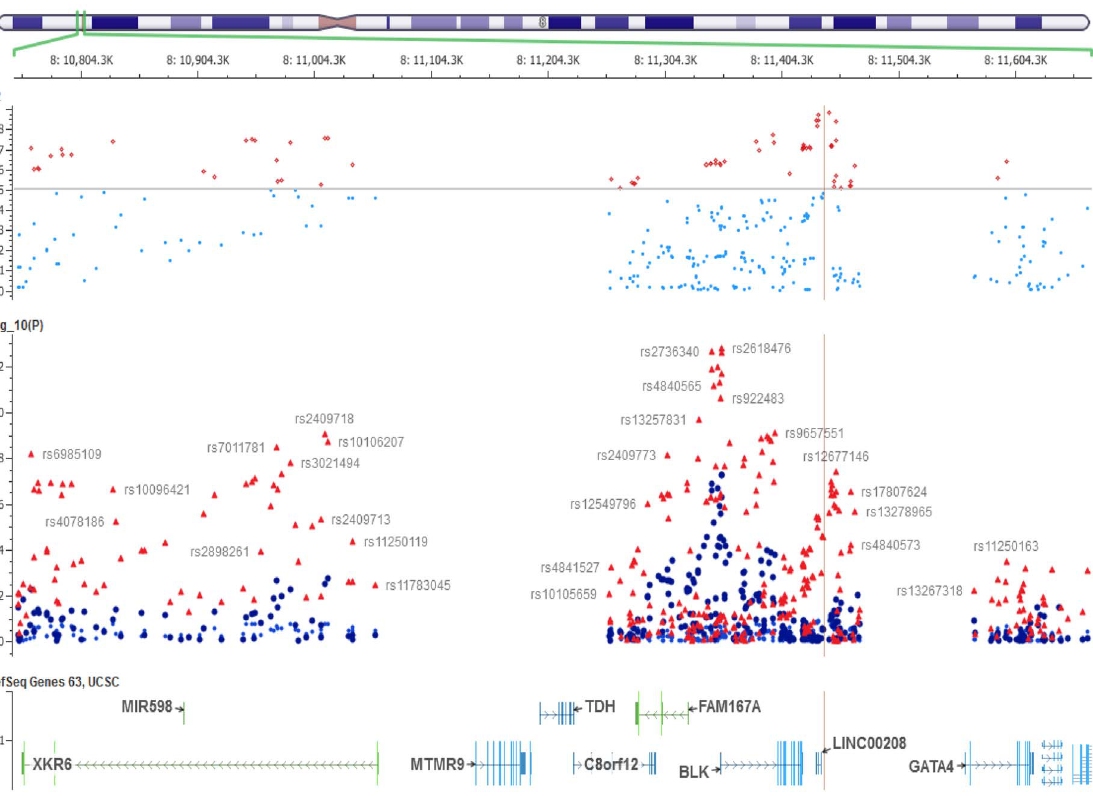
Fig. 5. A schematic representation of the association map for Lupus at 8p23 before and after conditional analyses. Red dots 5 original association, Blue dots 5 Association effects after conditioning on inversion. R2 5 correlation coefficient as a measure of linkage disequilibrium between inversion status and all markers in Caucasian population. The highest region in LD with inversion is shown with vertical line at